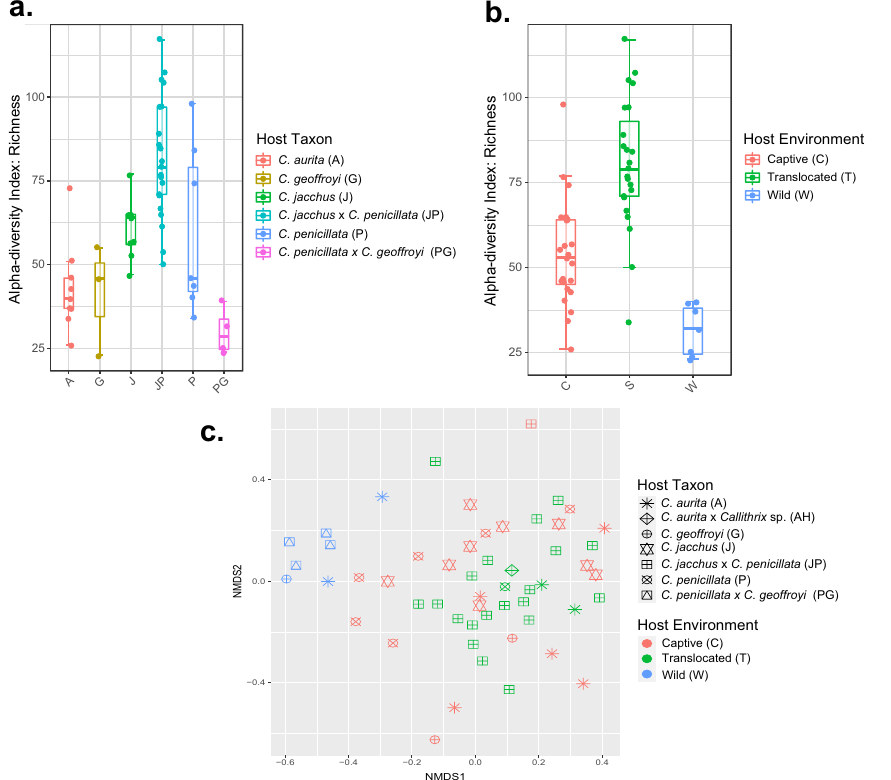
Figure 2. Boxplots of gut microbiome richness by host taxon ( a ) and host environment ( b ). Panel ( c ) shows a NMDS ordination plot for gut microbiome beta-diversity measured by the Bray-Curtis dissimilarity index. Legend of host classifications are shown on the right side of each